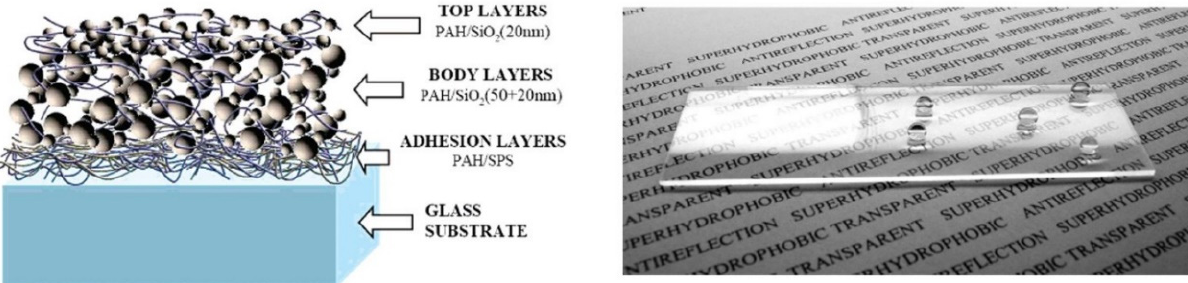
Figure 7. Schematic representation ( left ) of the transparent super-hydrophobic film and picture ( right ) of a glass slide coated with it showing both its transparency and super-hydrophobicity. Here, PAH stands for poly(allylaminehydrochloride) and SPS for Poly(sodium4-styrenesulfonate). Adapted with permission from Ref. [42]. 2007, American Chemical Society.